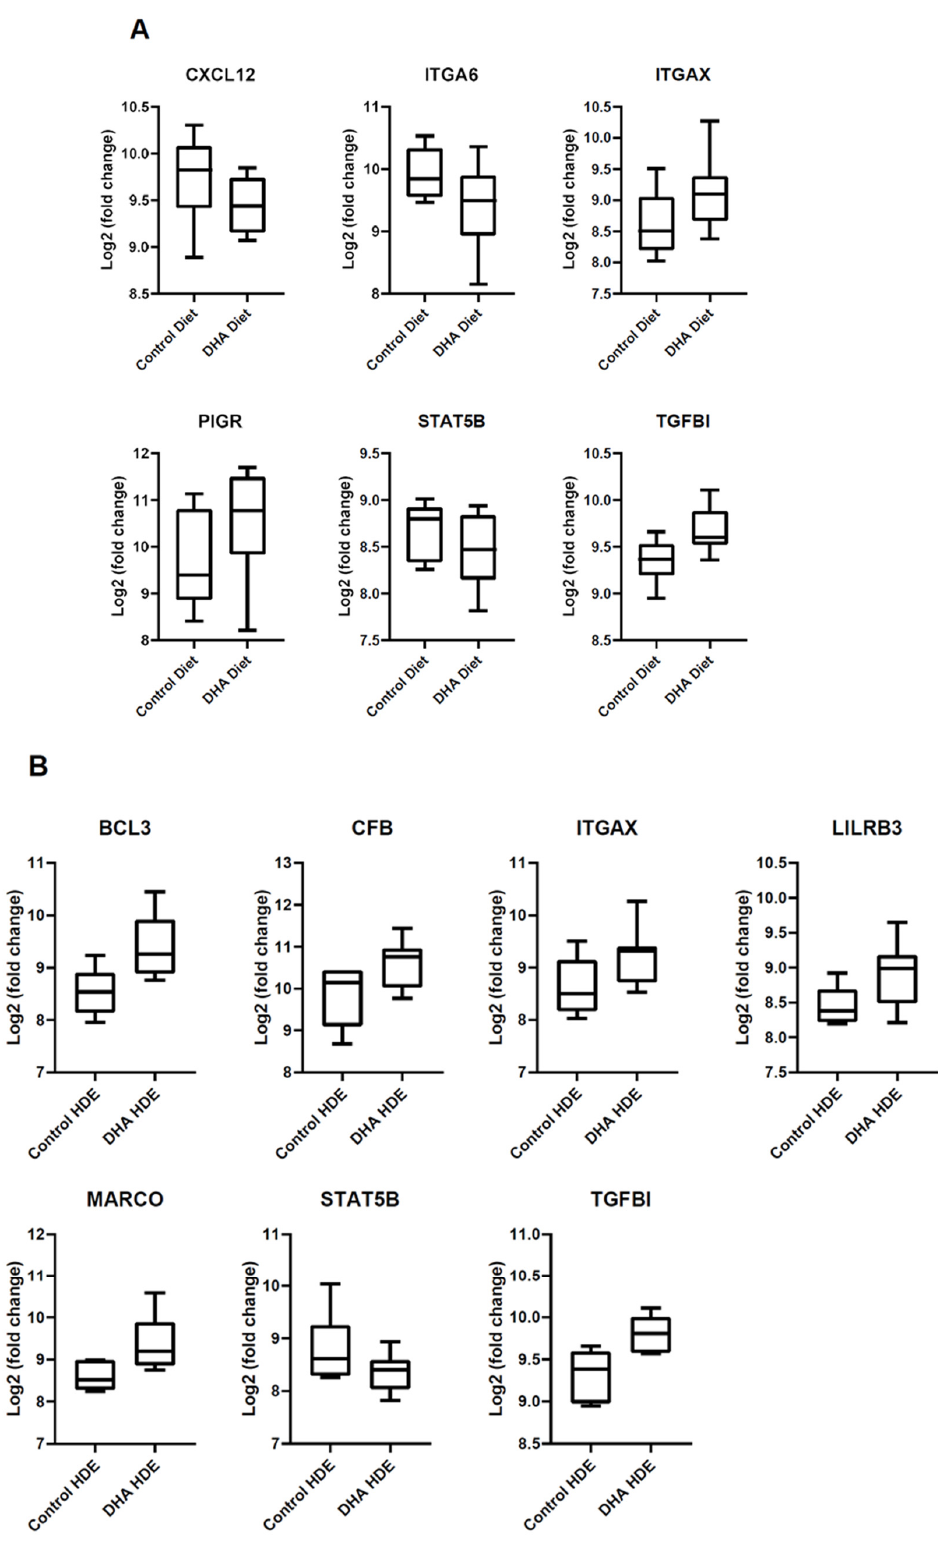
Figure 6. Box plots representing statistically significant ( p ≤ 0.05) alterations in gene expression in HDE- or saline-challenged mice fed a high-DHA diet or control diet containing no DHA. Normalized Log2 values were exported from nSolver and plotted. ( A ) List of 6 genes that were significantly altered among all 20 DHA vs. control diet samples. ( B ) The 7 di ff erentially regulated genes within the 13 DHA vs. control diet samples exposed to